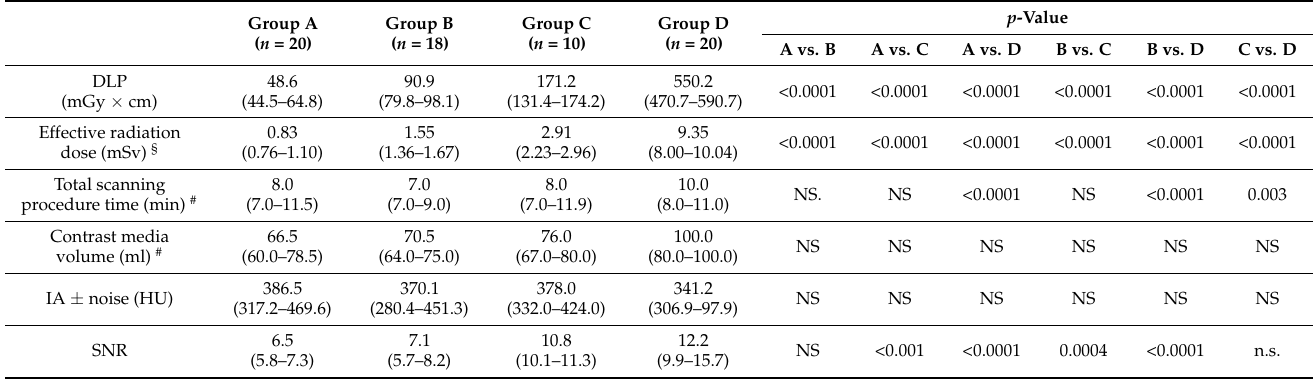
Table 2. CT procedure